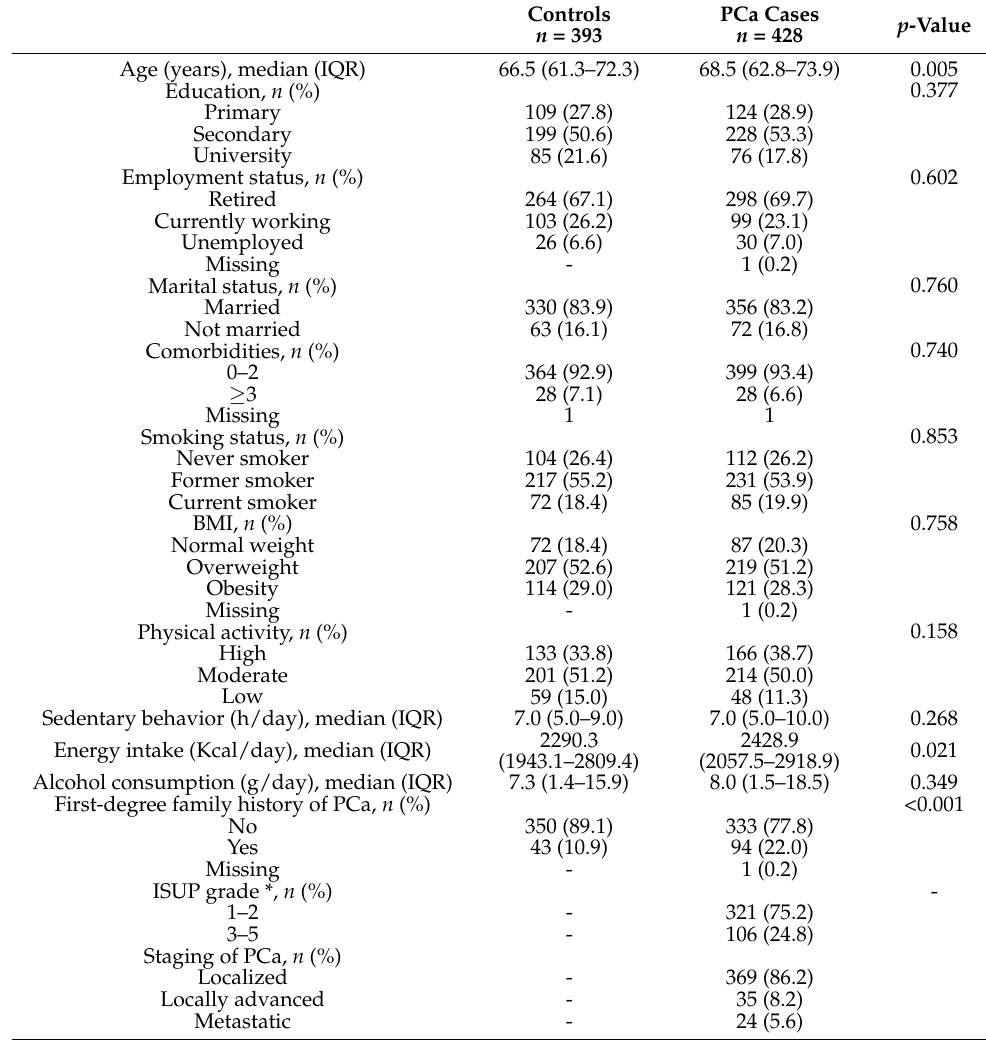
Table 1. Characteristics of PCa cases and controls in the CAPLIFE